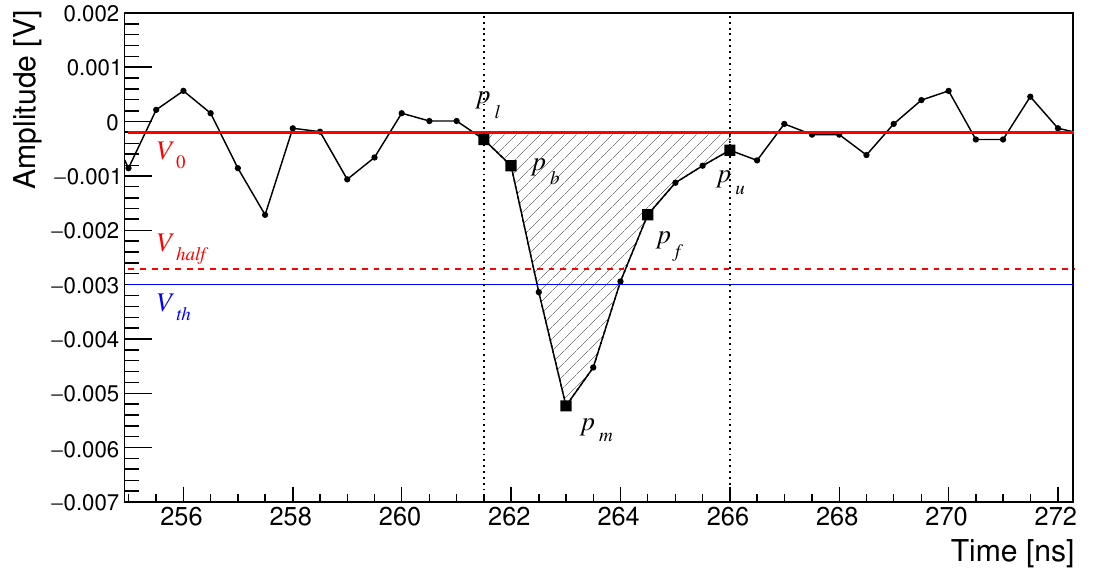
Figure 6 . Waveform sample including a peak with a single trigger. The shaded area shows the integral range used to evaluate the charge sum of the peak